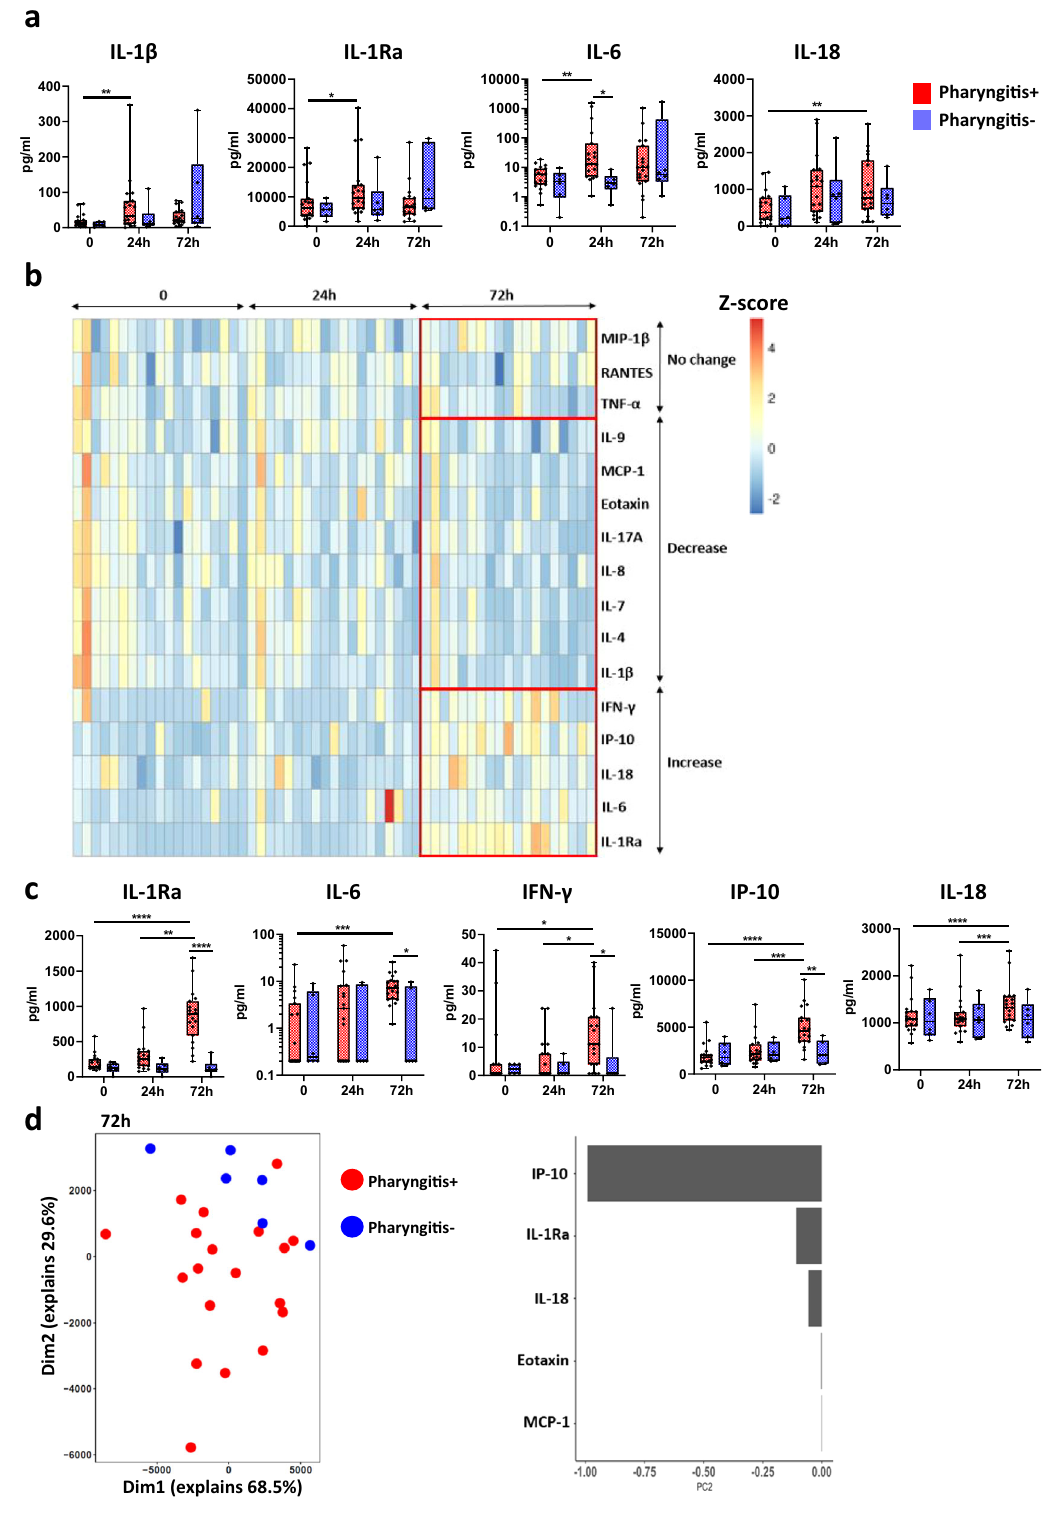
Fig. 2 Distinct cytokine pro fi les in participants that developed pharyngitis. a Saliva cytokines and chemokines at timepoint 0 h (pre-infection) 24h post- infection (24 h) and 72h post-infection (72 h) between pharyngitis positive ( n = 19, red) and negative ( n = 6, blue) participants. b Heatmap summary of serum cytokines and chemokines analysed with normalized Z-score. c Serum cytokines and chemokines that had increased during infection. d Unsupervised PCA analysis of serum cytokines and chemokines between pharyngitis positive and negative participants at 72h post-infection and the top 5 factors contributing to differences. Data presented as boxplots show median±IQR with min – max whiskers. A Friedman ’ s test was used to compare responses over time in P + and P − groups, while a Mann – Whitney U-test was performed to compare differences between P + and P − groups. All tests performed were two- tailed and a p -value <0.05 was considered signi fi cant; * p < 0.05, ** p <0.01, *** p < 0.001, **** p <